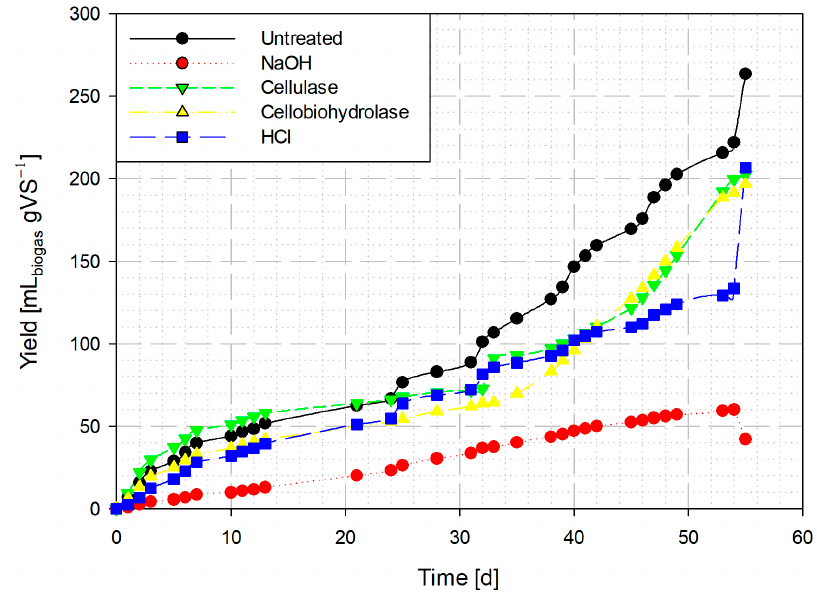
Figure 5. Biogas production yield in pretreated biomass of BSRc at room temperature.